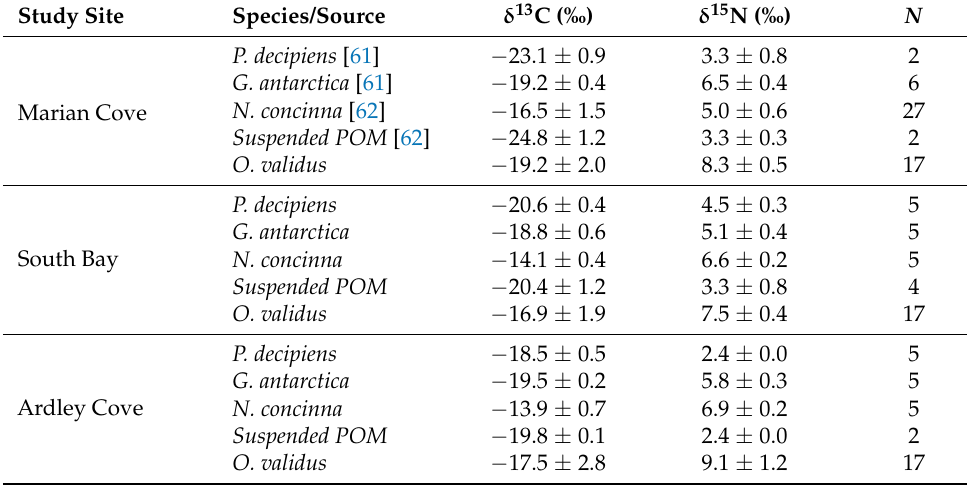
Table 4. Summary of the mean and standard deviation (mean ± SD) values of potential prey items and O. validus from each study